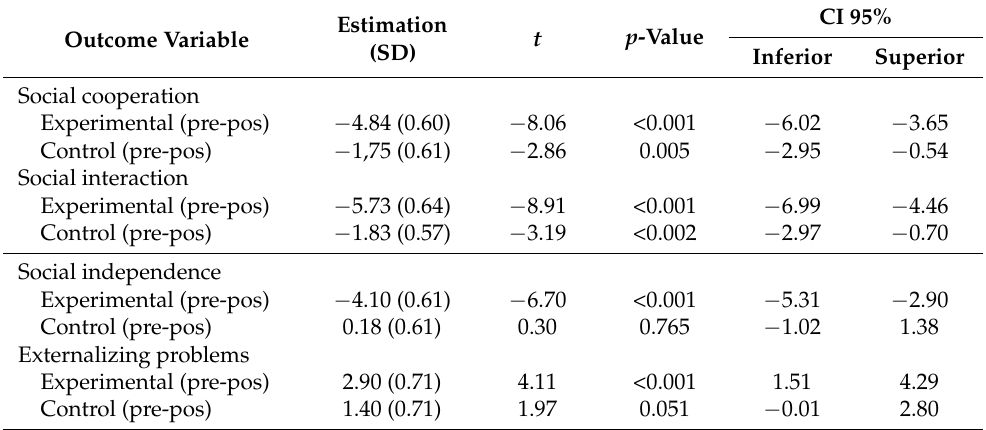
Table 8. Pairwise contrast of the group*time interaction, using means estimated by the model on social skills and externalizing